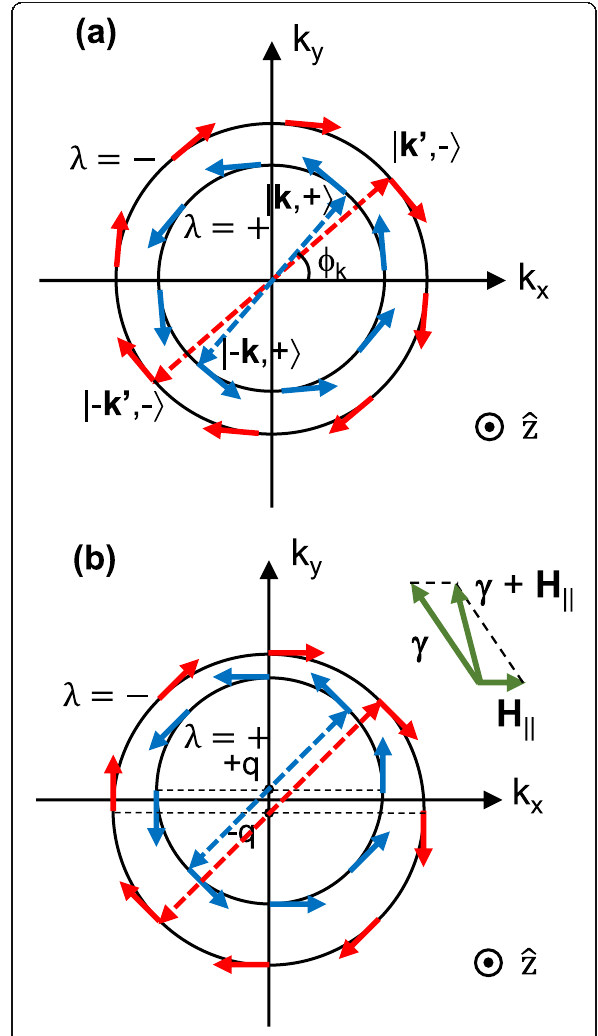
Fig. 2 Schematic illustrations of the effects of Rashba-type SOC on superconductivity. a Cooper pair formation on the spin-split FSs. Only the pairing within the λ = + band (between | k , + and | − k , + ) or the λ = − band (between | k ′ , − and | − k ′ , − ) is allowed. b Shift of the spin-split FSs due to an in-plane magnetic field. Each FS shifts by ± q in the directions perpendicular to the filed. The dashed arrows indicated the Cooper pair formations on individual helicity bands. The green arrows illustrate the summation of the effective inner field γ and the external field H